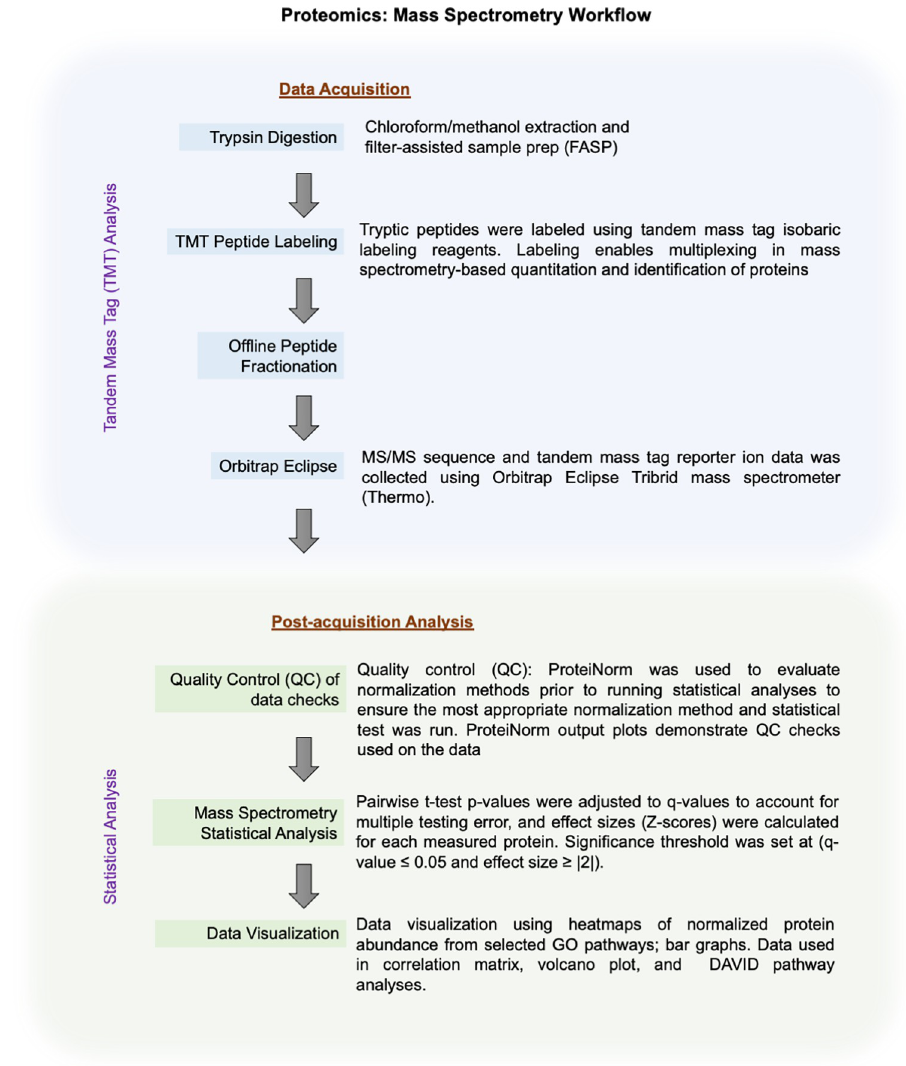
Fig 2. Mass spectrometry workflow. Flowchart to illustrate the steps of mass spectrometry (data acquisition), and the statistical analysis (post-acquisition